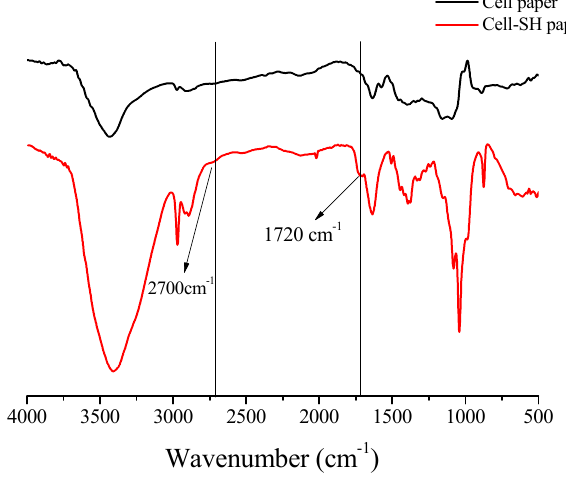
Figure 1. FT-IR spectra of ( a ) pristine cellulose paper; and ( b ) cellulose paper grafted with thioglycolic acid.